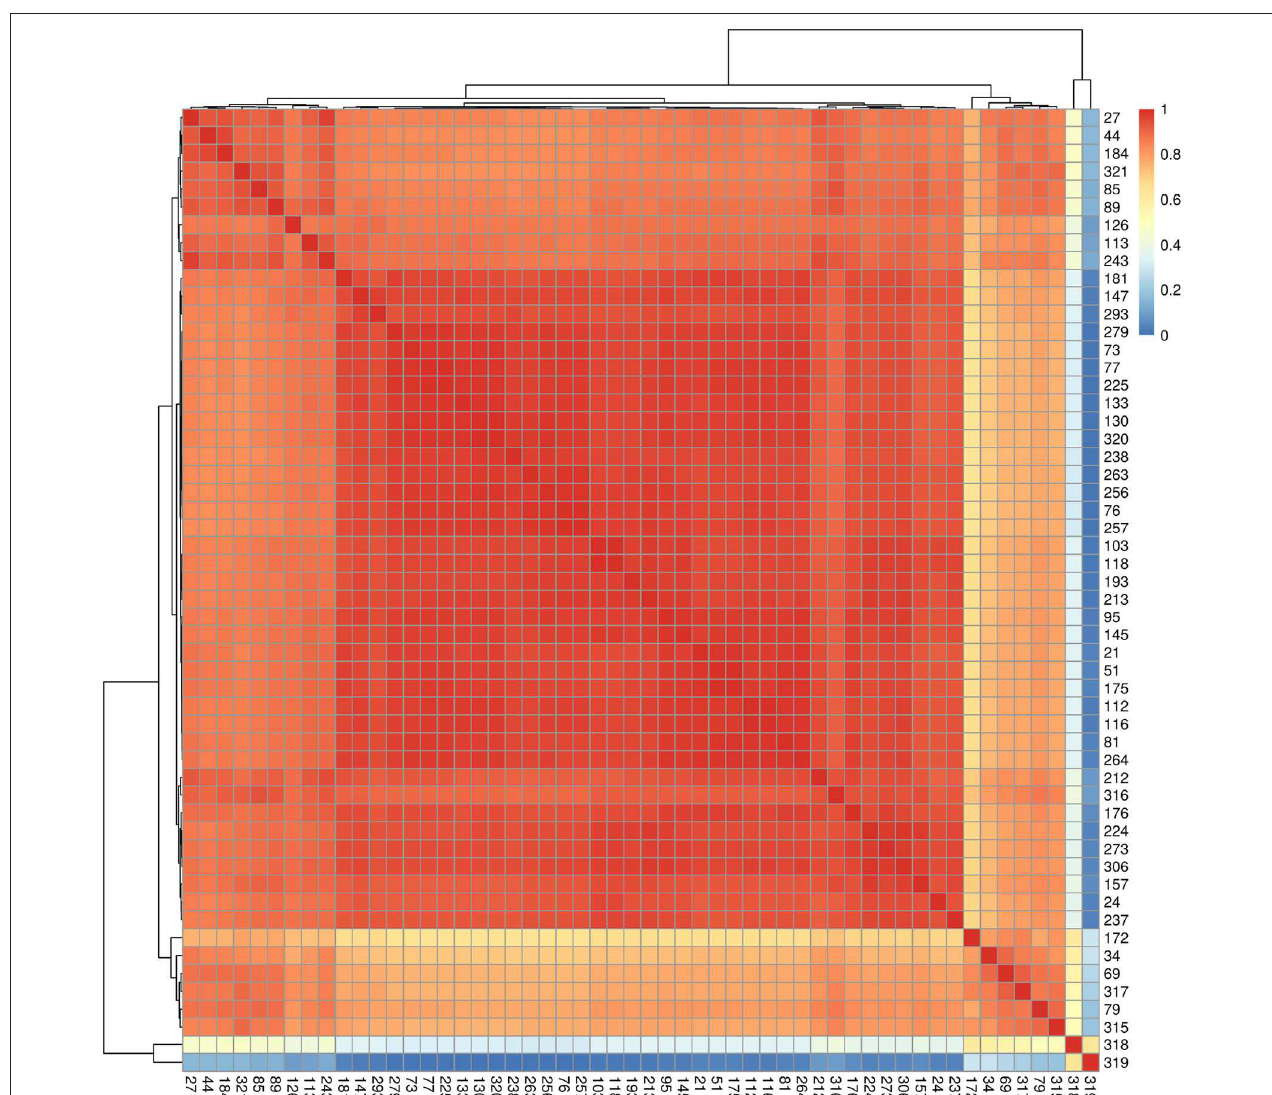
FIGURE 2 | Heatmap of distance matrix for the full weighted graph of Ha